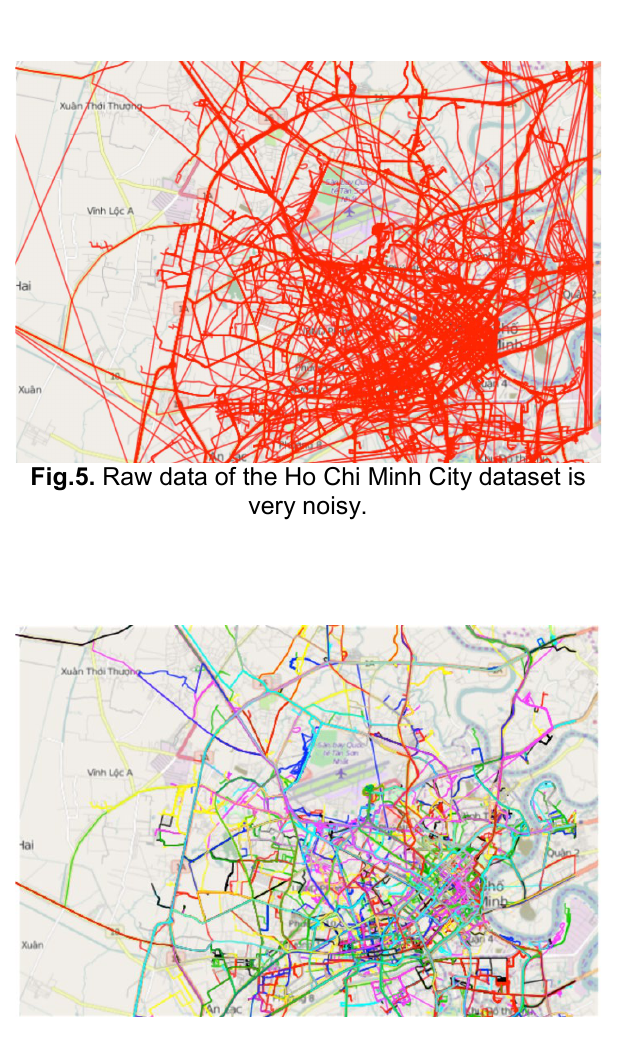
Fig.6. The Dataset after the pre-processing step.